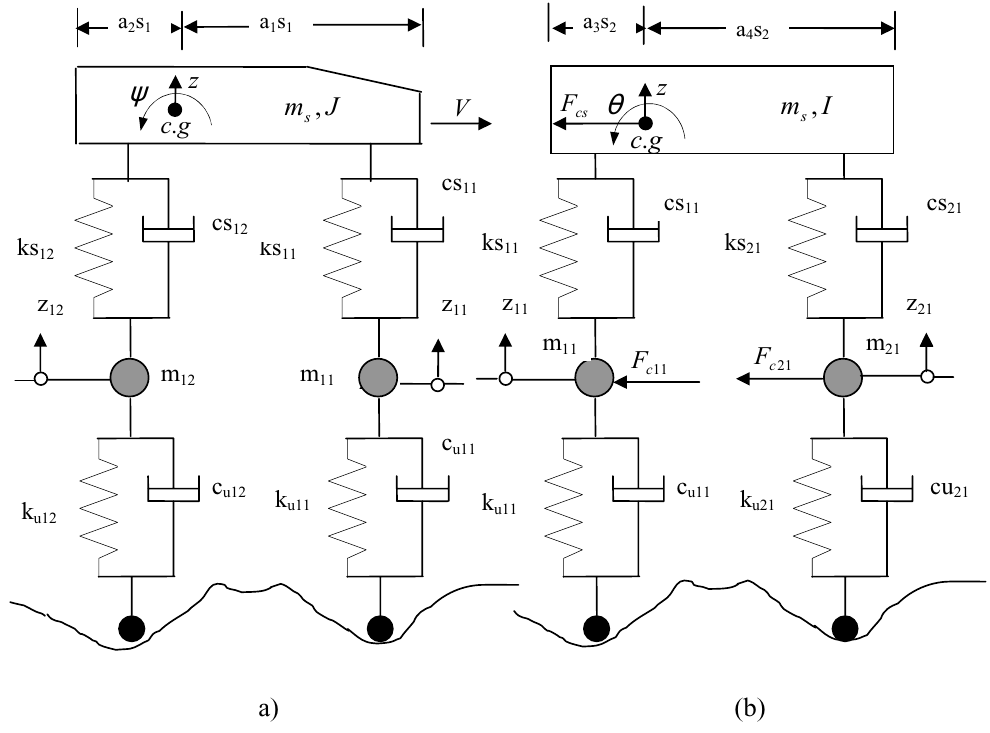
Fig. 1. 3-D Vehicle model with seven degrees of freedom (a) Side view (b) End